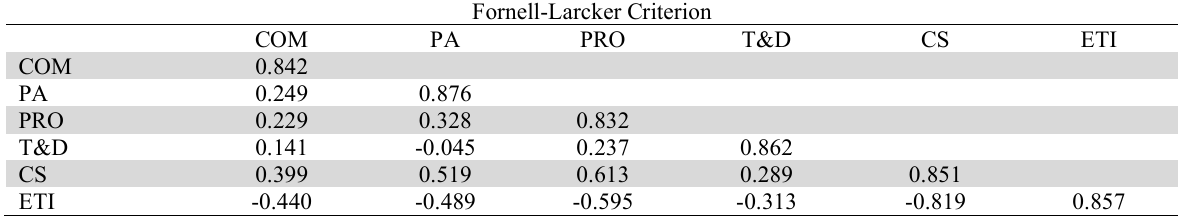
Discriminant Validity Based on Fornell-Larcker Criteria